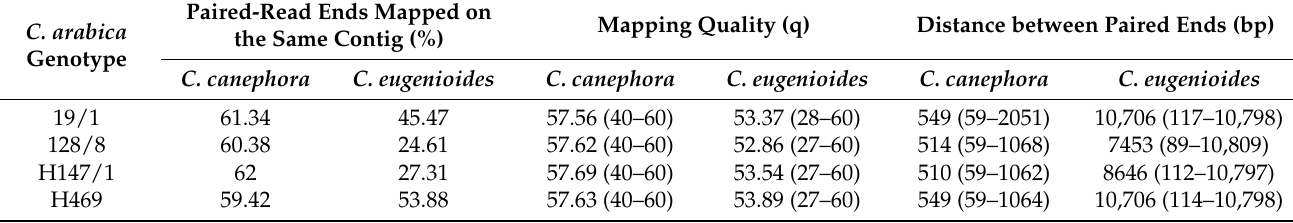
Table 3. Affinity of paired-end reads to target contigs of Coffea canephora and C. eugenioides . Mapping quality and distance between paired ends shows average and 95% CI